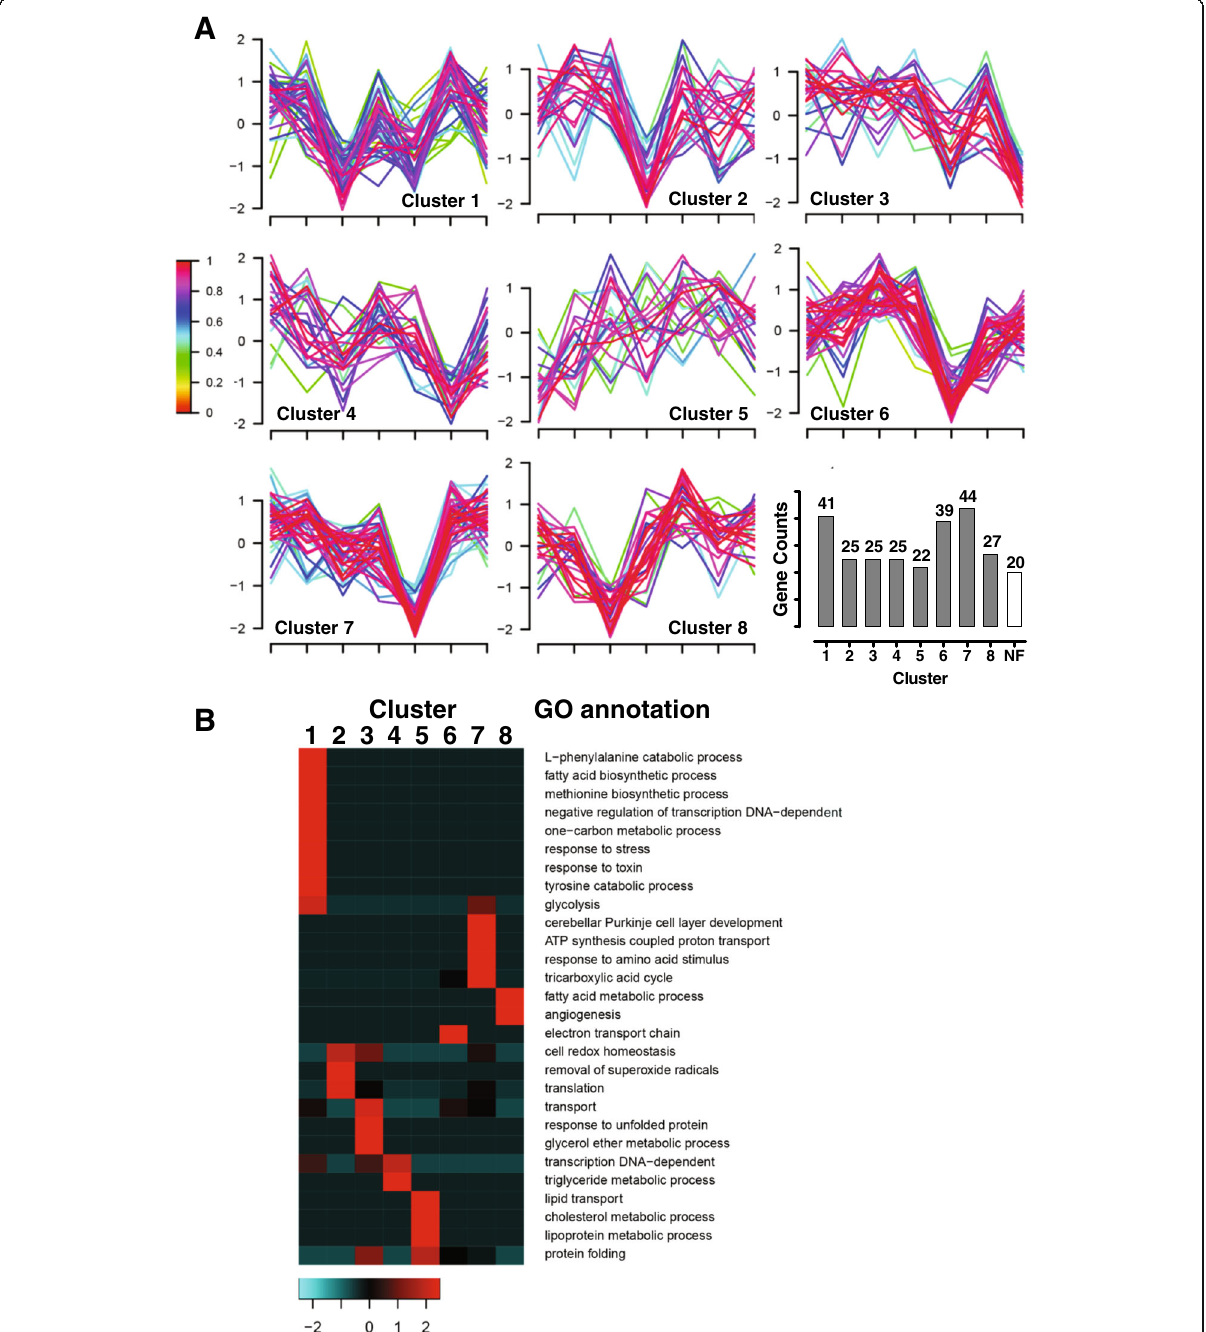
Fig. 4 Cluster analysis of SS-regulated proteins in time-toxicity study. a Cluster analysis and profiles. Legend (left) indicates fitness to cluster center. Numbers of protein counts in each cluster were plotted with cluster number (NF indicates non-fit proteins). b Enrichment of GO biological pathways to cluster